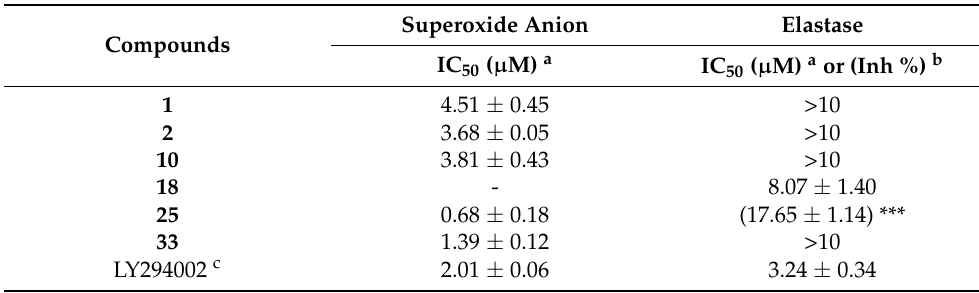
Table 2. Inhibitory effects of compounds 1 , 2 , 10 , 18 , 25 , and 33 from E . formosana on superoxide anion generation and elastase release by human neutrophils in response to